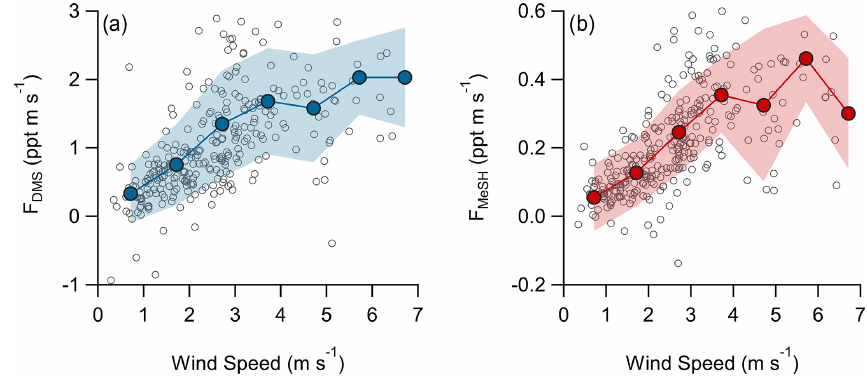
Figure 5. Flux of (a) DMS and (b) MeSH as a function of wind speed. Open circles are individual 30min data points and closed circles are mean fluxes binned by wind speed at a 1ms − 1 bin spacing. Shaded regions are ± 1 σ of the binned mean.